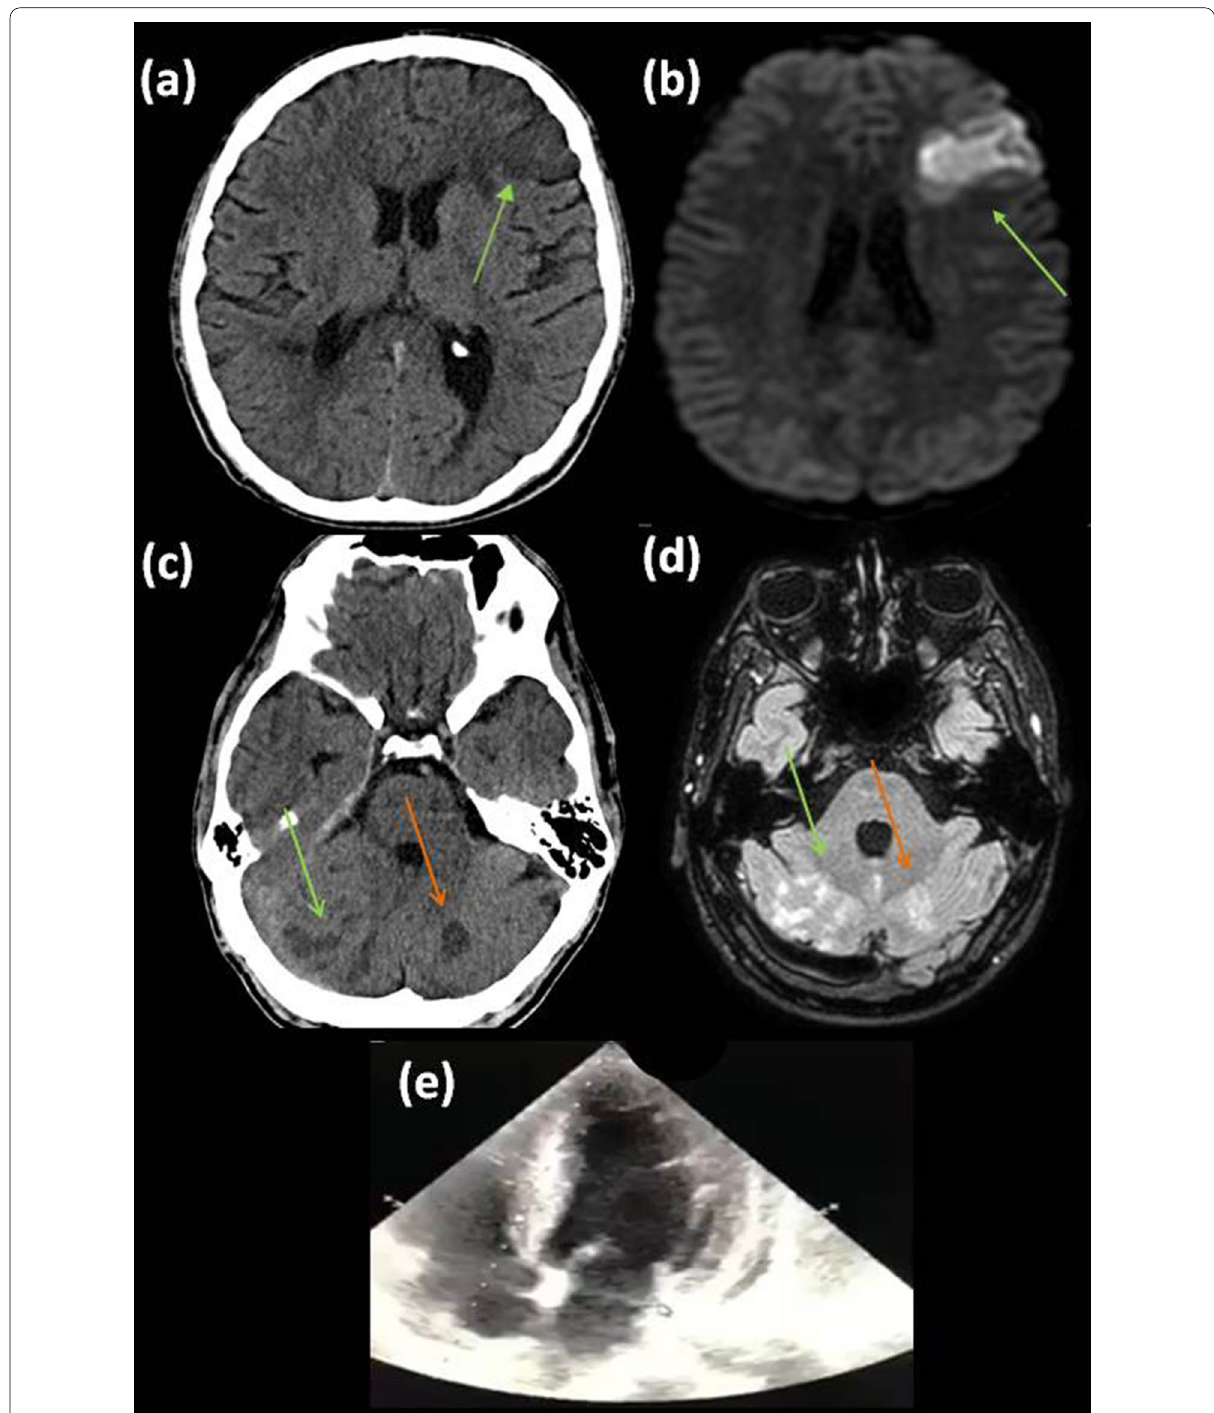
Fig. 2 Post-IVT CT and DWI images demonstrating appearance of a new hypodense lesion ( a ) exhibiting true restriction ( b ) respectively, extending over an area irrigated by the superior trunk of the left MCA. Multiple new hypodense (CT)/high signal intensity lesions (FLAIR) within the right cerebellar hemisphere (PICA territory) and vermis (green arrows) and an older infarcted area on the left (orange arrows) ( c , d ). TTE exhibiting full LVT lysis ( e